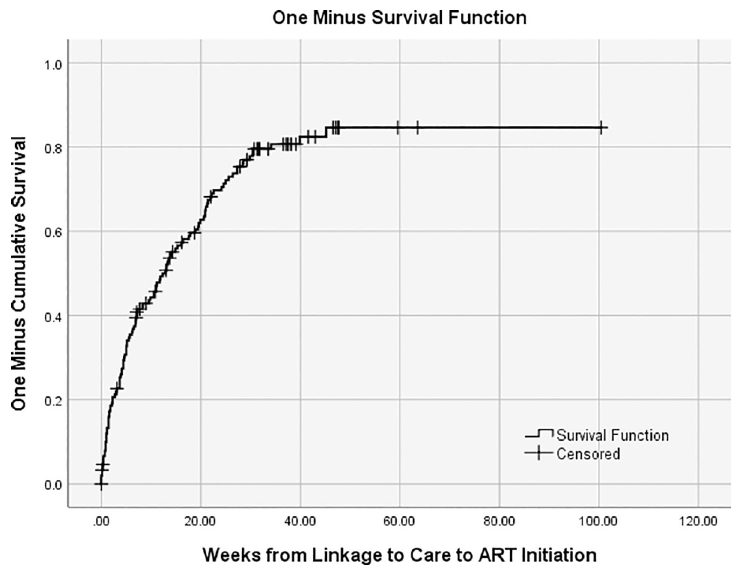
Fig 1. Time (weeks) from linkage to care to ART